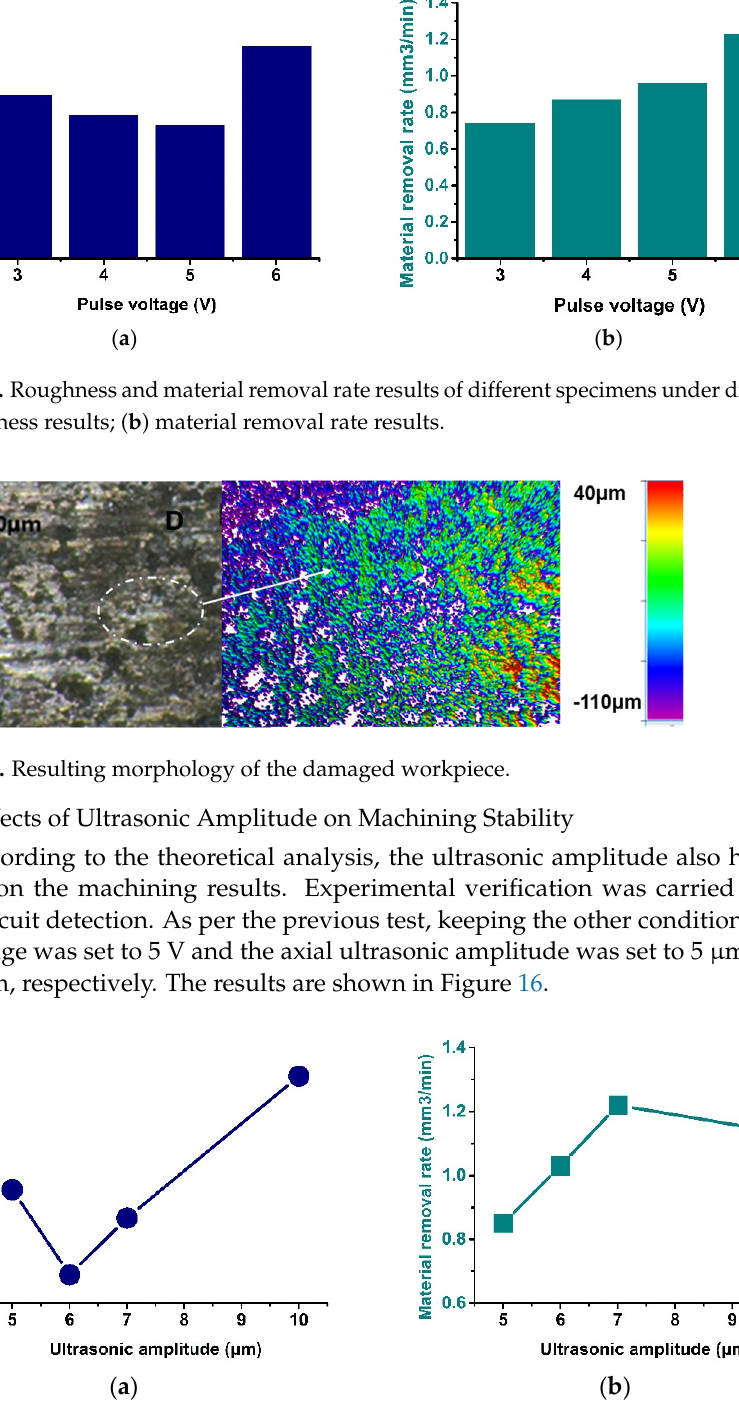
Figure 13. Resulting morphology for different feed rate voltage: ( a ) 3 V; ( b ) 4 V; ( c ) 5 V; ( d ) 6 V.